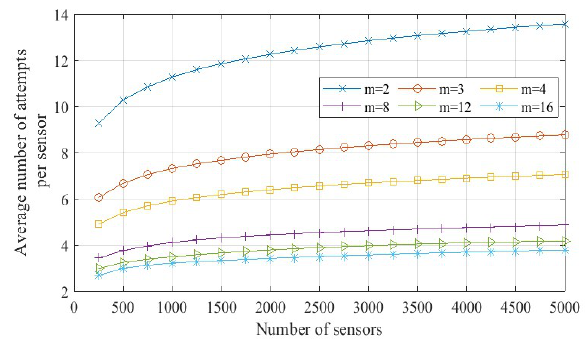
Figure 5. Average number of attempts per sensor during the collision resolution time